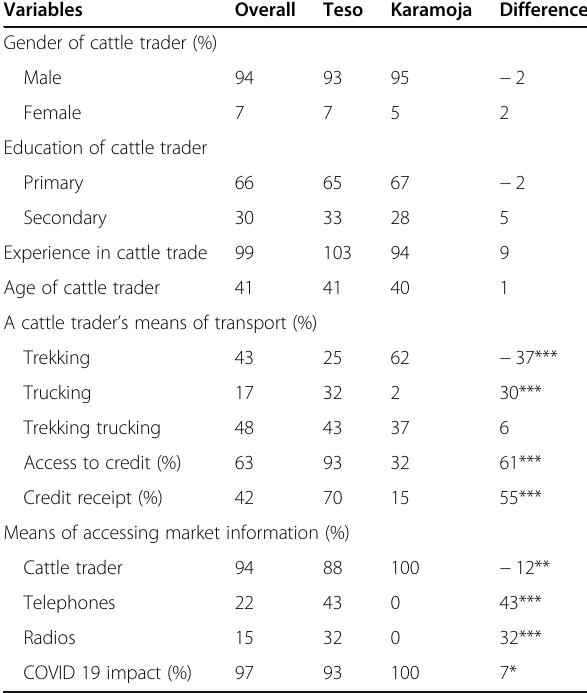
Table 2 Characteristics of the cattle traders by sub-region